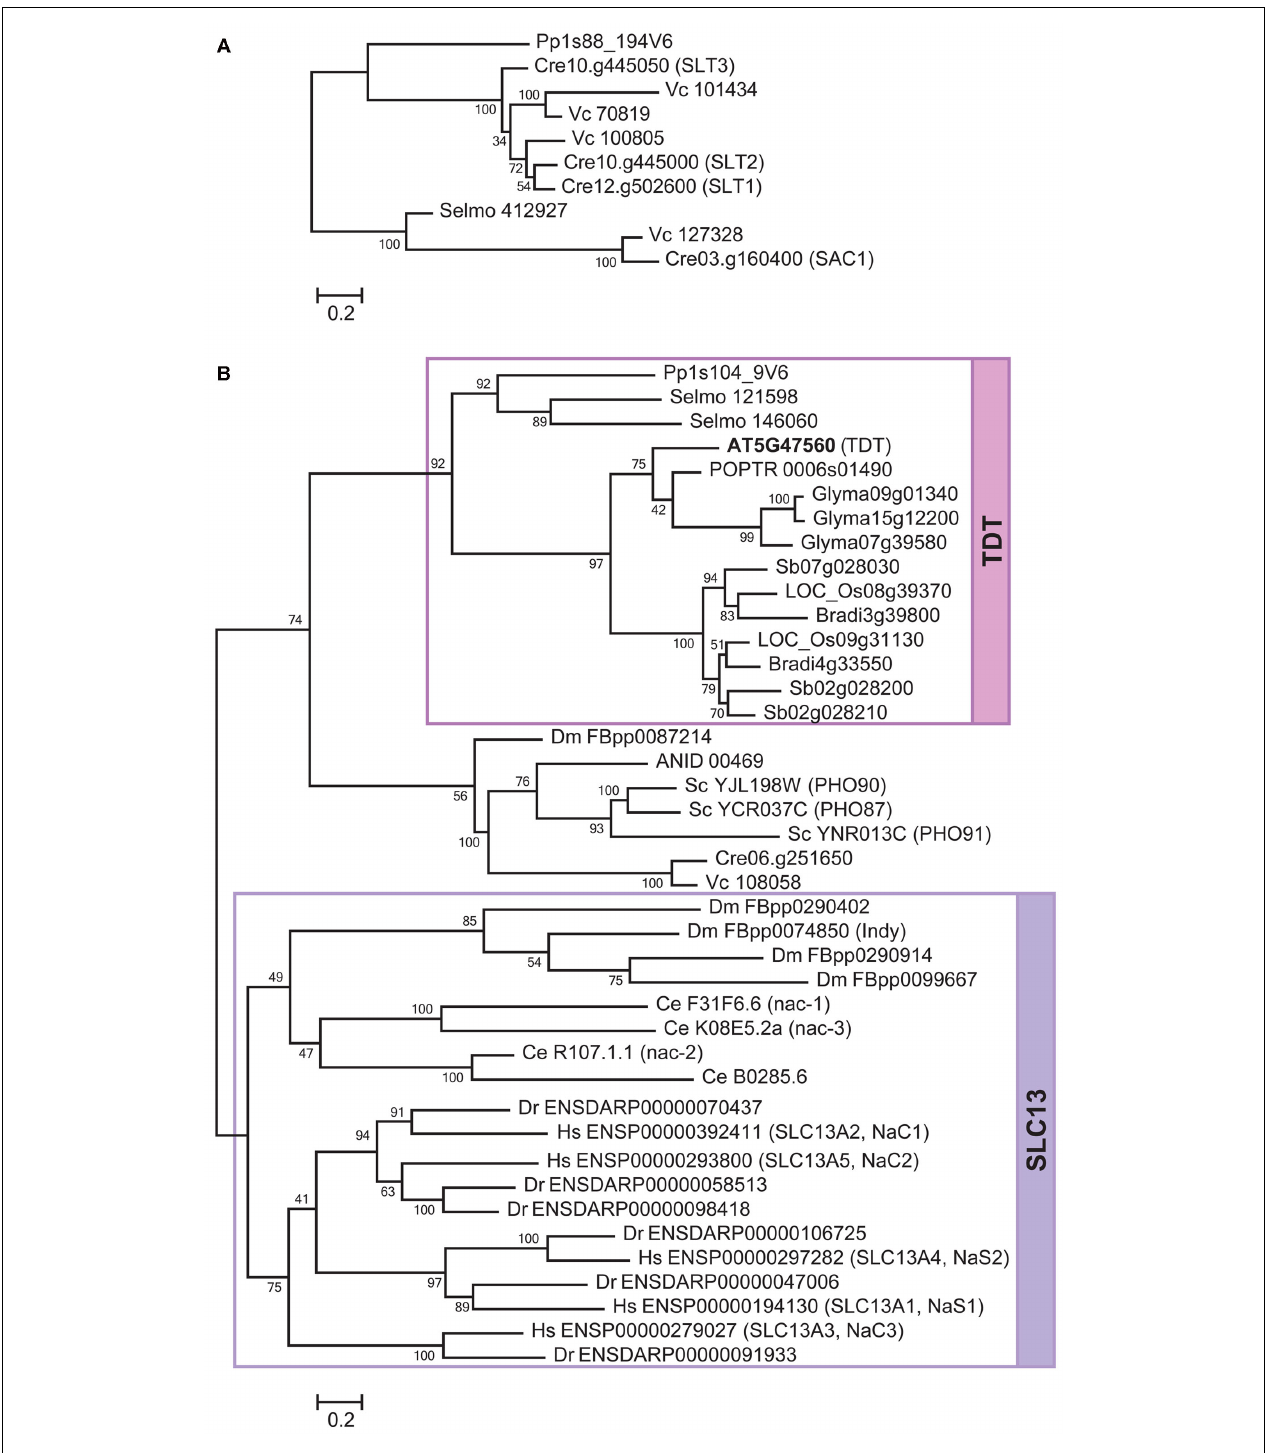
nodes.The locus numbers or gene IDs are described the same as in Figure 2 . The locus number of Arabidopsis TDT is highlighted in bold letters.The names of Chlamydomonas SAC1 and SLT, Arabidopsis TDT, and animal SLC13 family members are shown in the parentheses next to the locus